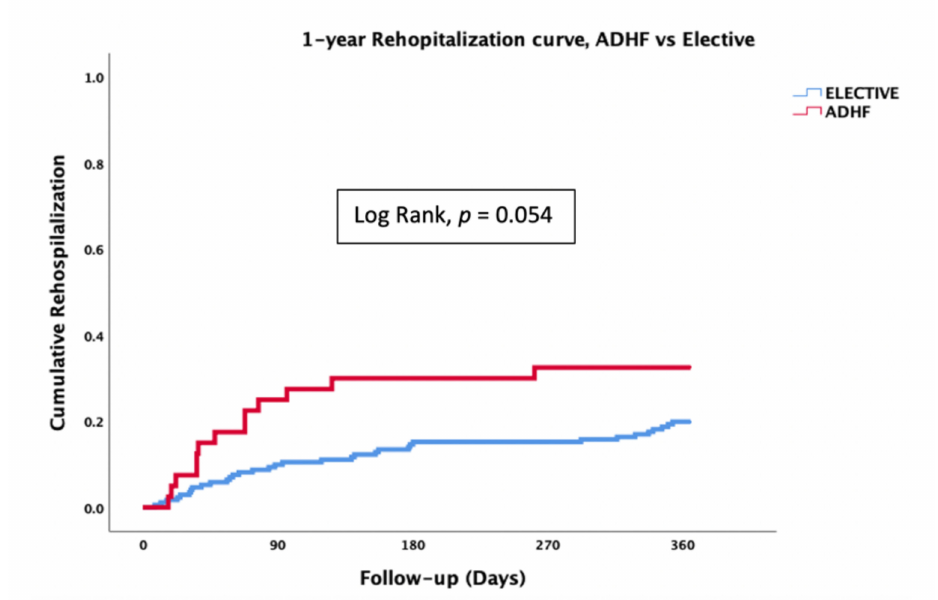
Figure 3. Kaplan–Meier analysis for 1-year HF-related rehospitalizations of 237 patients who un- derwent PMVr for severe MR between 2015 and 2020 by the ADHF group and elective patients ( p = 0.054). ADHF = acute decompensated heart